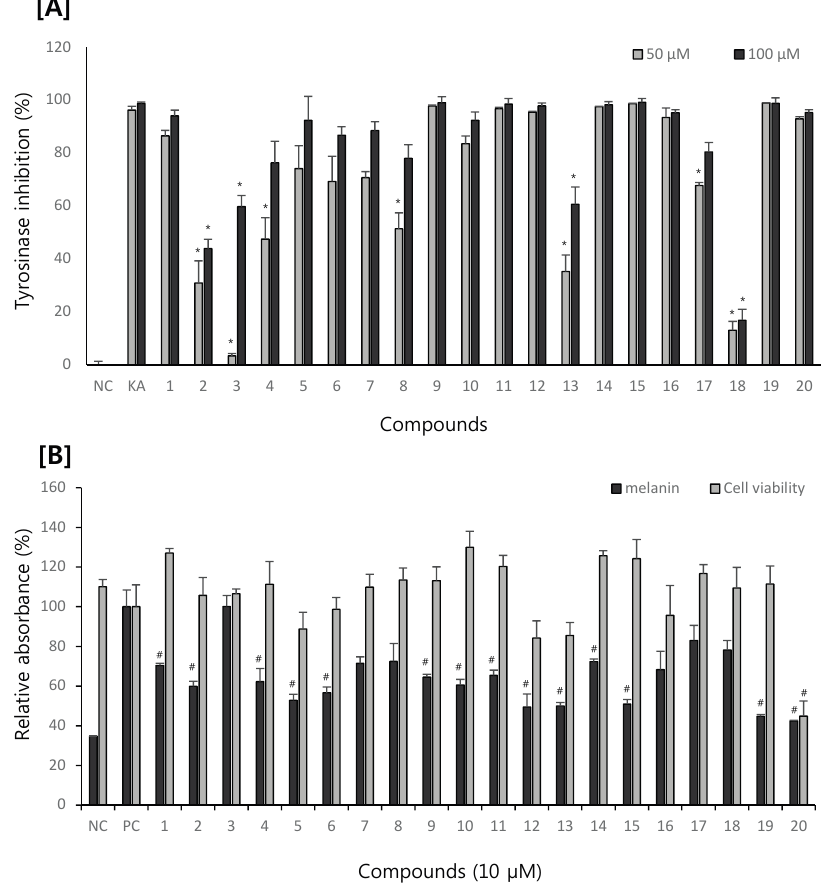
Figure 2. Effects of compounds 1 – 20 on ( A ) tyrosinase inhibition and ( B ) melanin content in B16F10 melanoma cells. Data was expressed as mean ± S.D. (n = 3). NC, normal control; PC, α -MSH stimulated positive control; KA, kojic acid. * p < 0.05 compared to NC (A), # p < 0.05 compared to PC